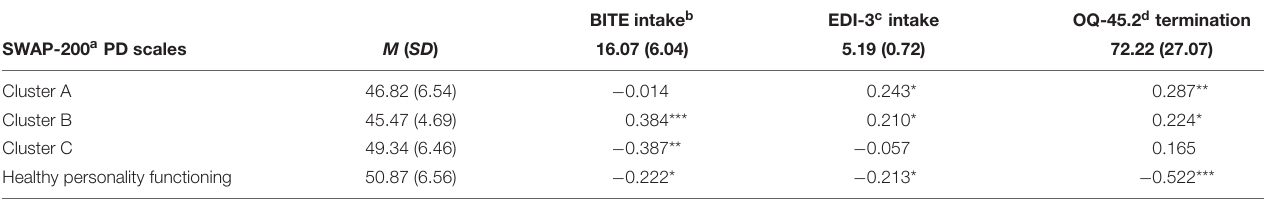
TABLE 1 | Means, standard deviations, and correlations between clusters of SWAP-200 PD scales, healthy personality functioning, baseline eating symptoms, and therapy outcome ( N = 107).